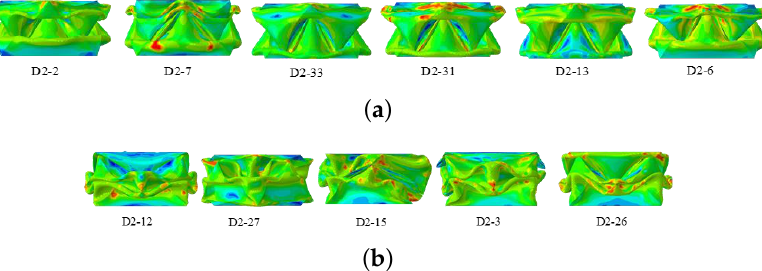
Figure 17. The final compression fragmentation graph of the model in Cluster 4 and Cluster 5: ( a ) Clus- ter 4; ( b ) Cluster